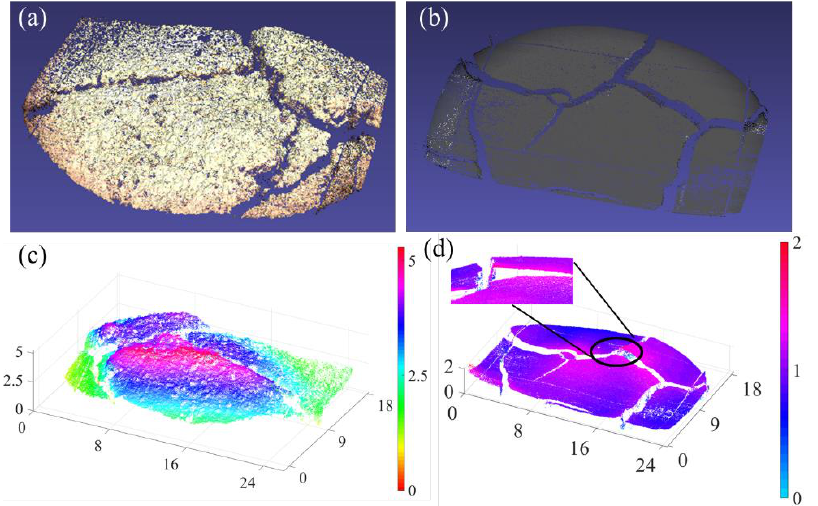
Figure 5. Reconstruction of soil samples. ( a ) Point cloud reconstruction of higher elevation samples. ( b ) Point cloud reconstruction of lower elevation samples. ( c ) Visualized data that show the depth and height information of the higher elevation samples. ( d ) Visualized data that show the depth and height information of the lower elevation samples. Black circle shows the effect of soil surface curling (Red points). The x, y and z scales are in the unit of millimeters.